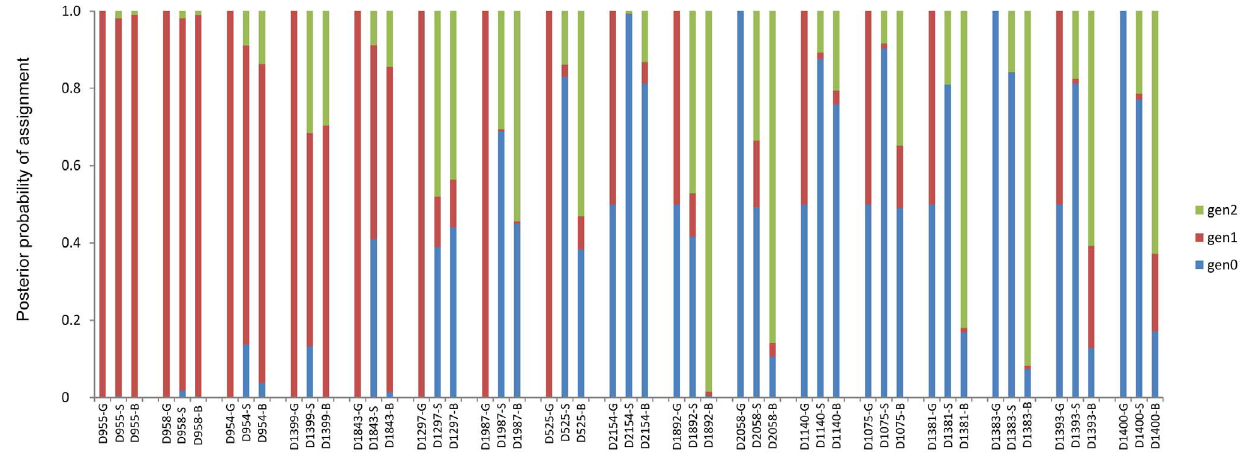
Figure 3. Individual ancestry states of putative migrants. Posterior distributions of individual assignment to nonimmigrant (gen0), and first (gen1) and second generation immigrant (gen2) ancestry states. Suffixes after indvidual names indicate assignment probabilties as obtained in GENECLASS (G), STRUCTURE (S) and BAYESASS (B).